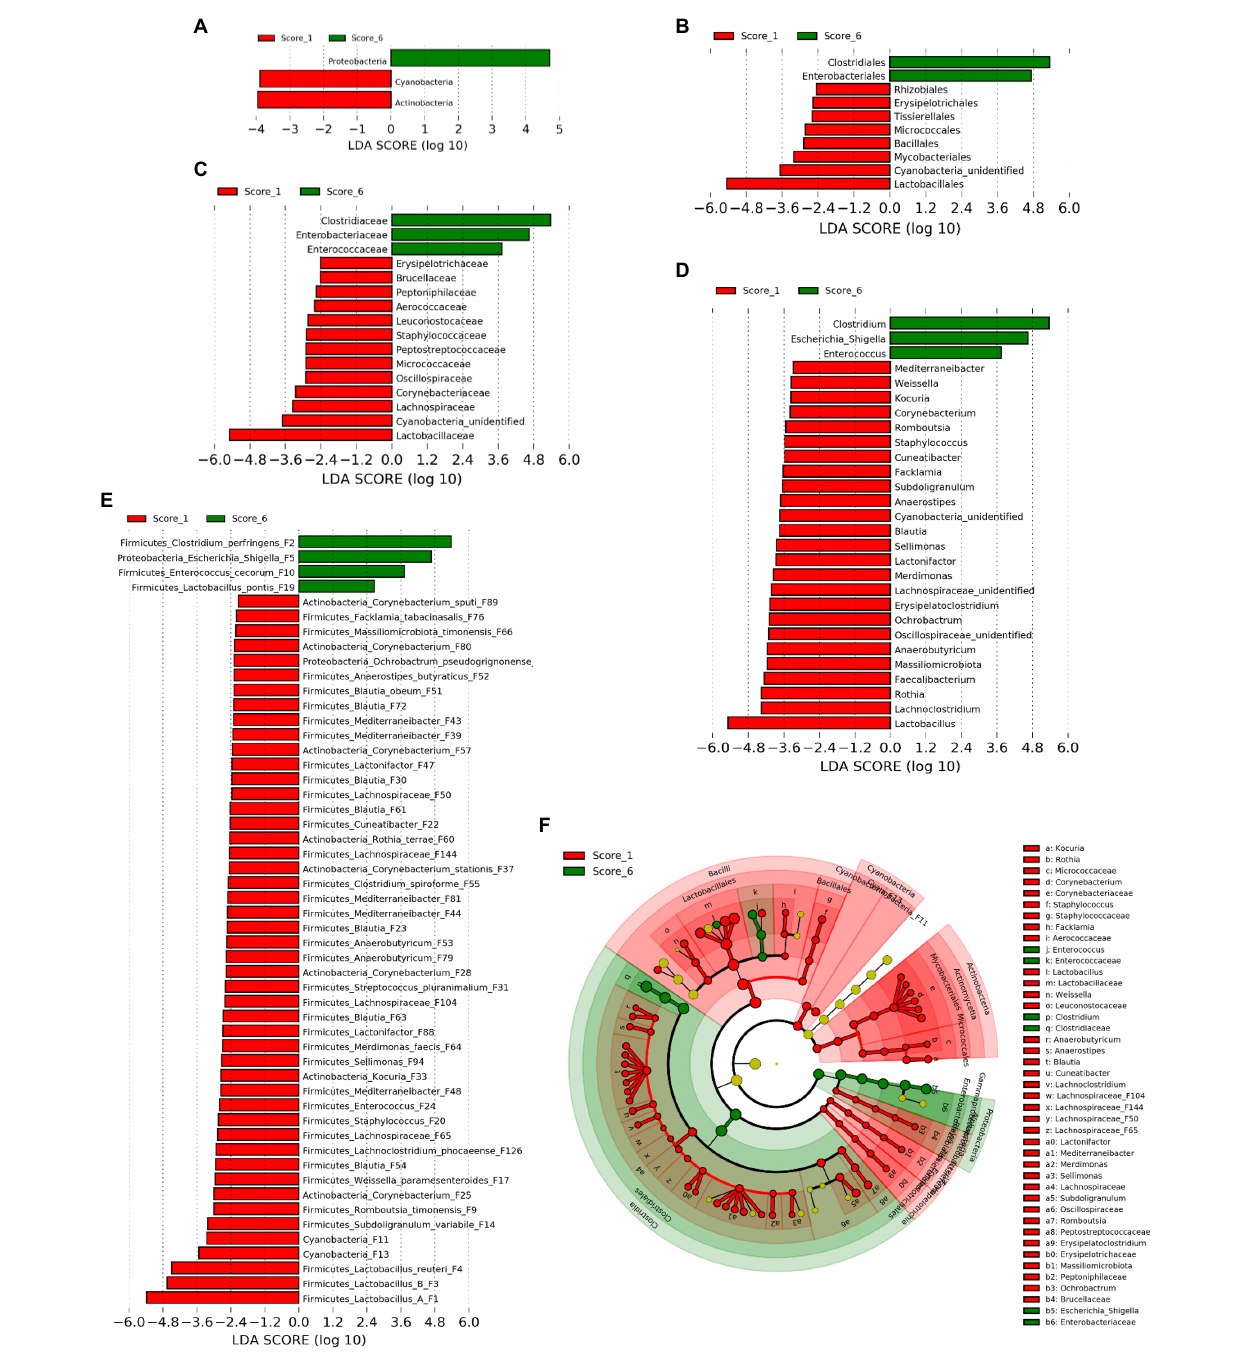
FIGURE 3 | Differential enrichment of the ileal bacteria between chickens with mild and severe NE. After induction of NE, the ileal digesta of broilers were collected and subjected to 16S rRNA gene sequencing. Intestinal lesions of individual animals were scored. Linear discriminant analysis (LDA) effect size (LEfSe) analysis was performed to identify differentially abundant bacteria at the phylum (A) , order (B) , family (C) , genus (D) , and ASV levels (E) between score-1 mild and score-6 severe NE chickens with cut-offs p < 0.05 and LDA score > 2.0. (F) Phylogenetic relationships of differentially enriched bacteria. Differentially enriched bacterial taxa were represented by rings with the phylum shown in the outermost ring and the species in the innermost